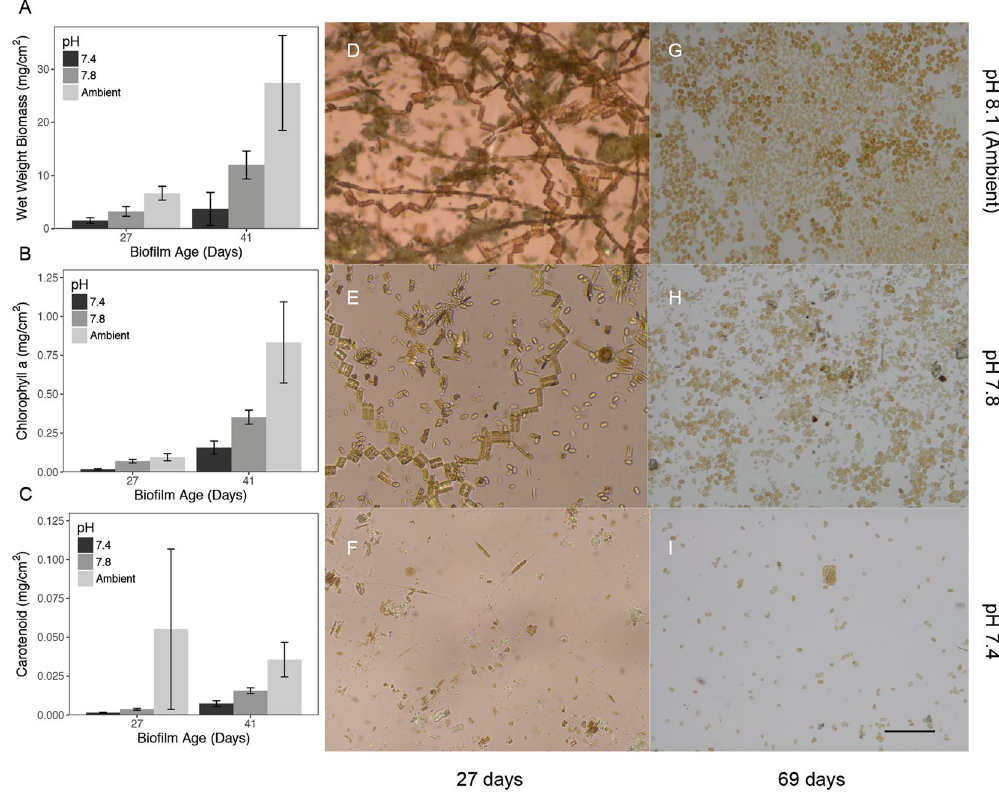
Figure 2. Effects of ocean acidification on biofilm development. ( A – C ) Changes in biomass and pigments associated to primary producers in response to pH treatment for young and old biofilms (n = 5 for each bar). ( D – I ) Representative images for biofilms at different pH for young and old biofilms. Ambient pH NIST was 8.1. Scale bar 50 μ